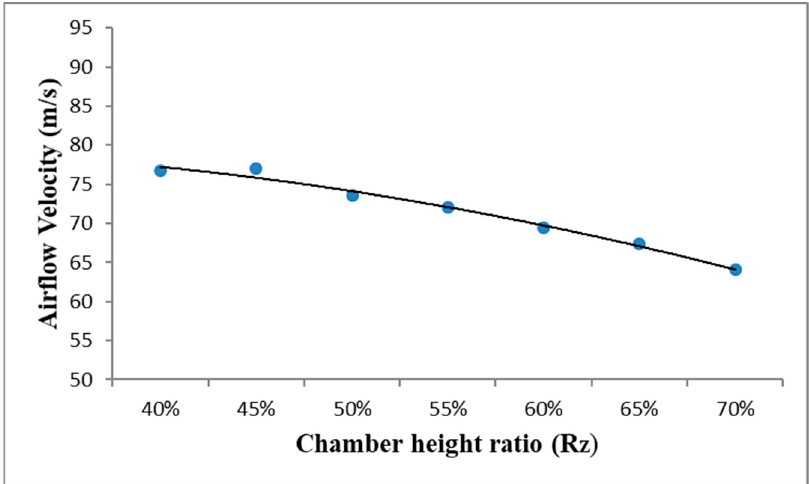
Figure 18. Airflow velocity corresponding to height-ratio R Z of OWC chamber. The maximum average velocity of the airflow is 76.97 m/s, corresponding to the ratio of chamber-height Rz = 0.45, while the second largest average velocity is 76.71 m/s, corresponding to the ratio Rz = 0.40 the smallest height of the chamber designed in the OWC